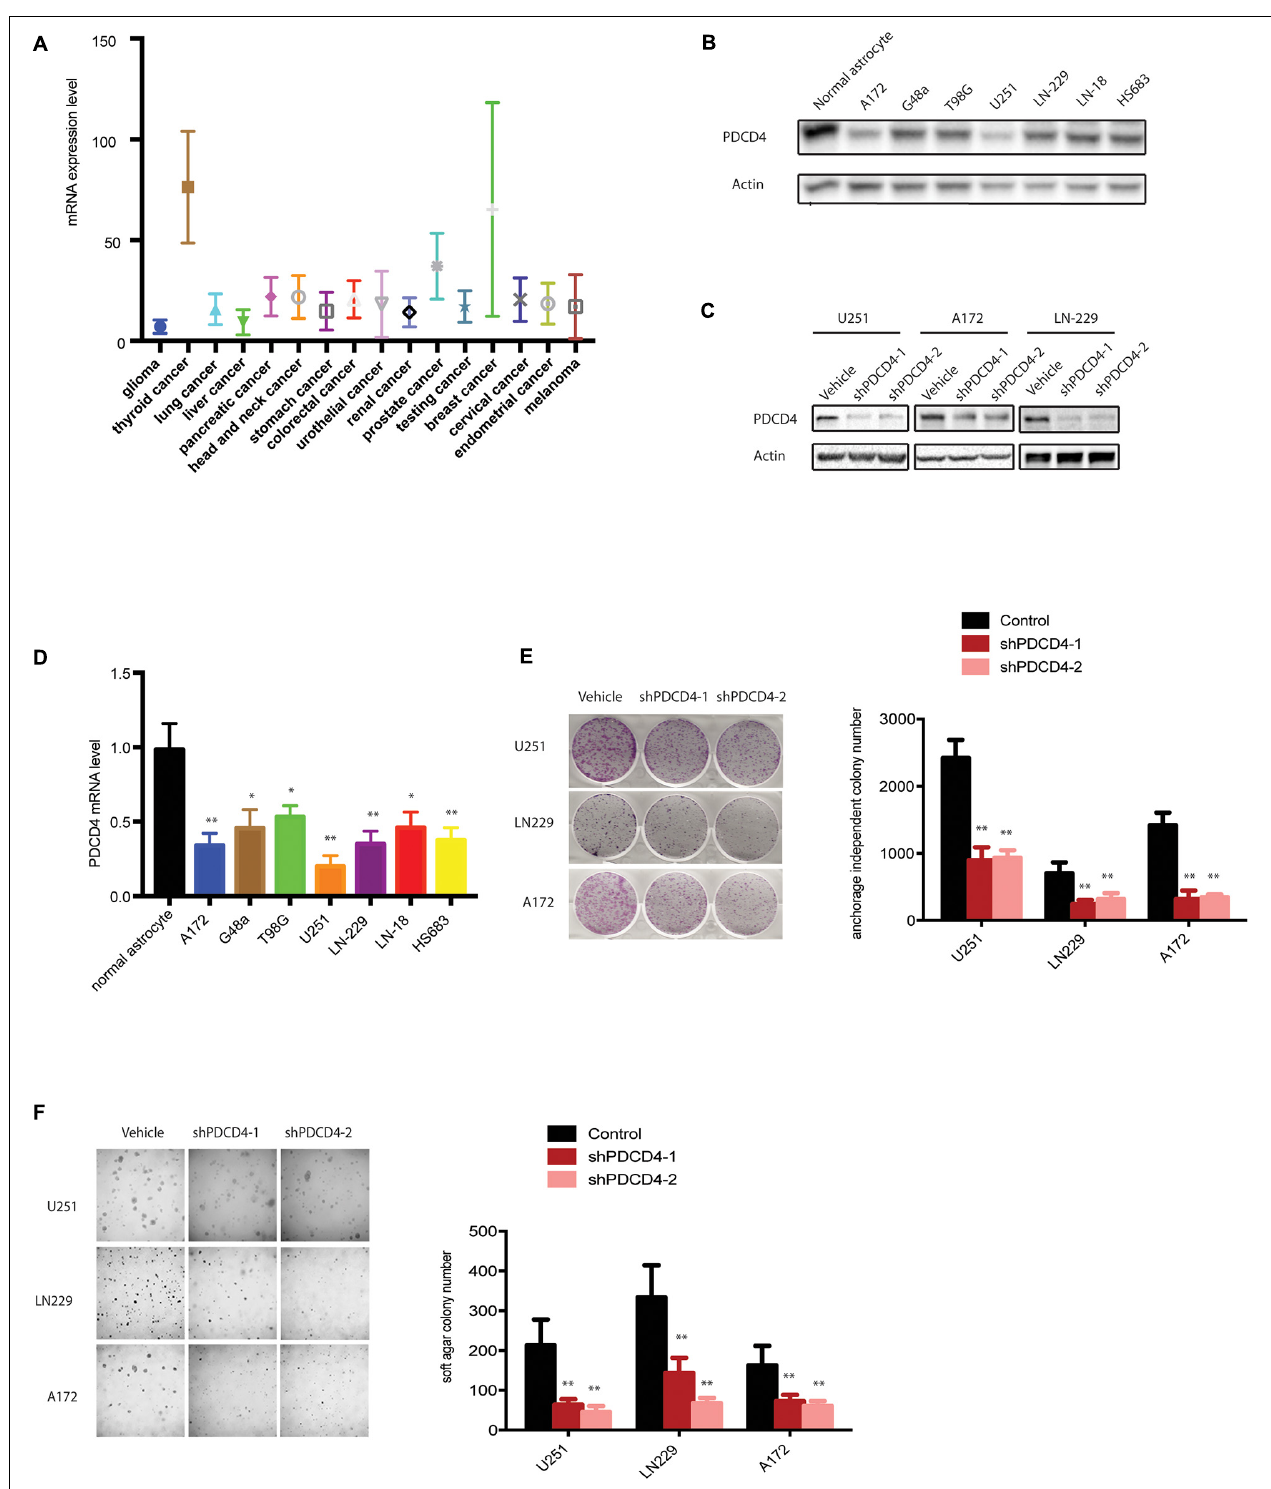
FIGURE 1 | PDCD4 is down-regulated in glioma cells and acts as a tumor suppressor. (A) Analysis of mRNA levels in 16 cancer types based on the TCGA dataset. (B) Western blot analysis showing PDCD4 protein levels in seven glioma cell lines vs. normal astrocytes. (C) Western blot analysis indicating change in PDCD4 protein levels in stable PDCD4 -knockdown cells. (D) Real-time PCR analysis depicting PDCD4 mRNA levels in seven glioma cell lines vs. normal astrocytes. (E) Colony formation in glioma cells transfected with scrambled or PDCD4 shRNAs. (F) Anchorage-independent growth in glioma cells transfected with scrambled or PDCD4 shRNAs. * P < 0.05; ** P < 0.01.